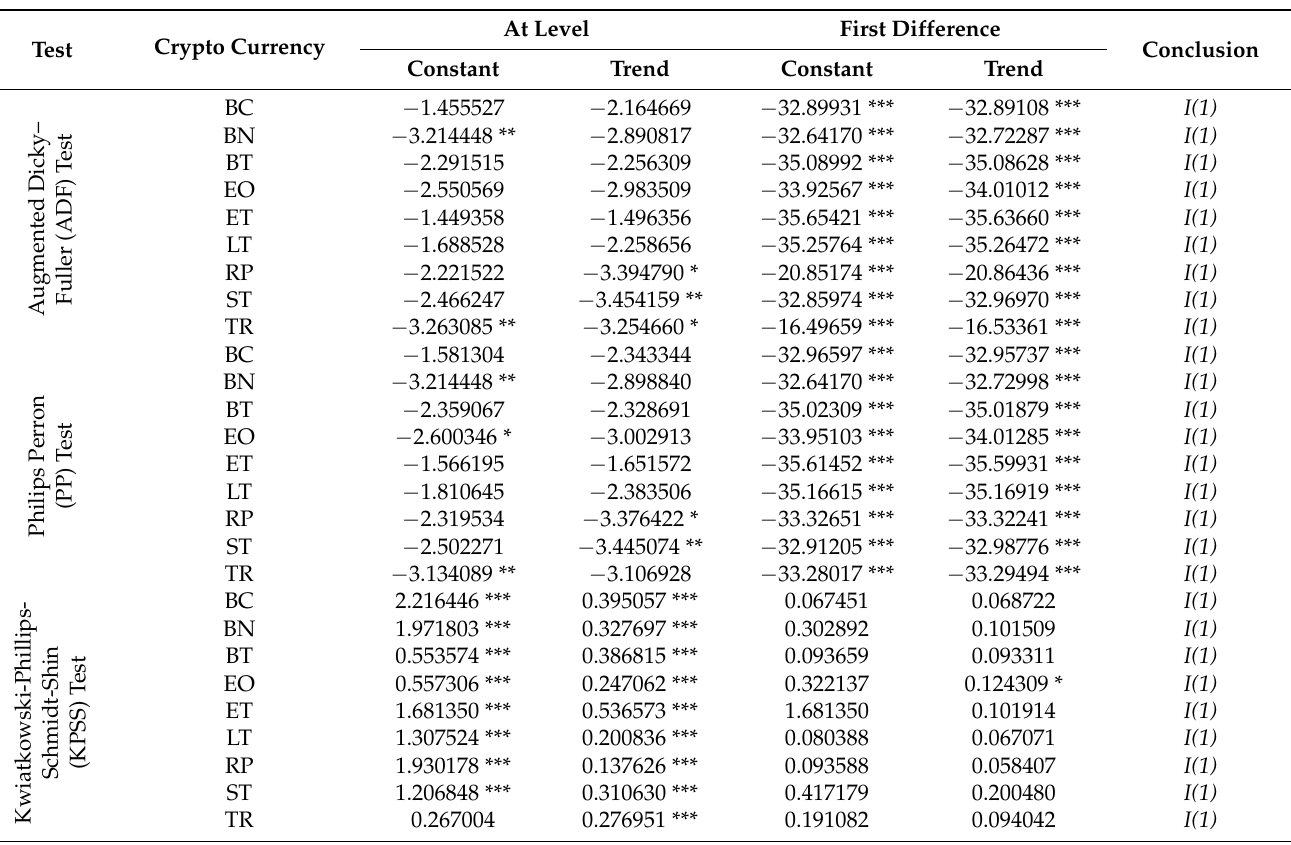
Table 3. Unit Root Tests